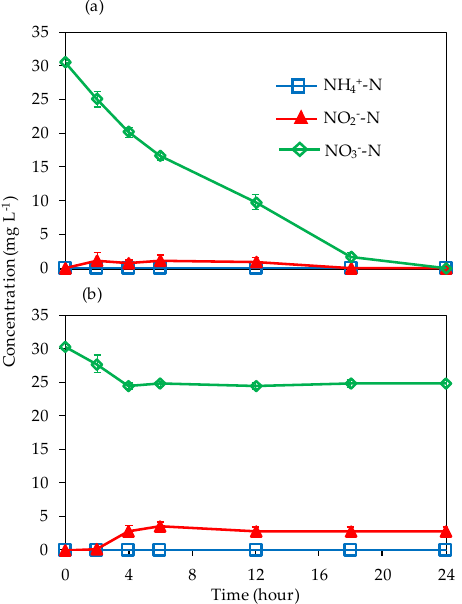
Figure 6. Changes in N concentrations over 24 h in denitrification experimental vial containing zeolite: ( a ) with common reed roots, and ( b ) without common reed roots, from the tidal flow CWs with and without vegetation, respectively, on the 60th day of operation. Values are means ±SD (n = 3).